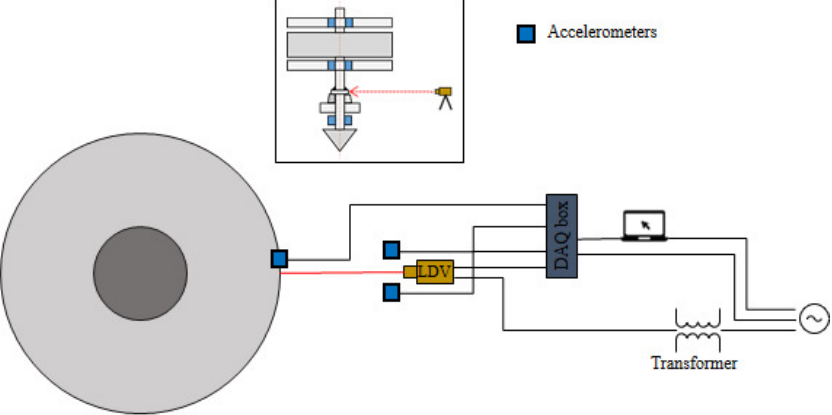
Figure 6. Layout of the instruments during vibration measurements, where the vibrometer is plugged into the isolation transformer. Vibrations are measured on the housing of the main